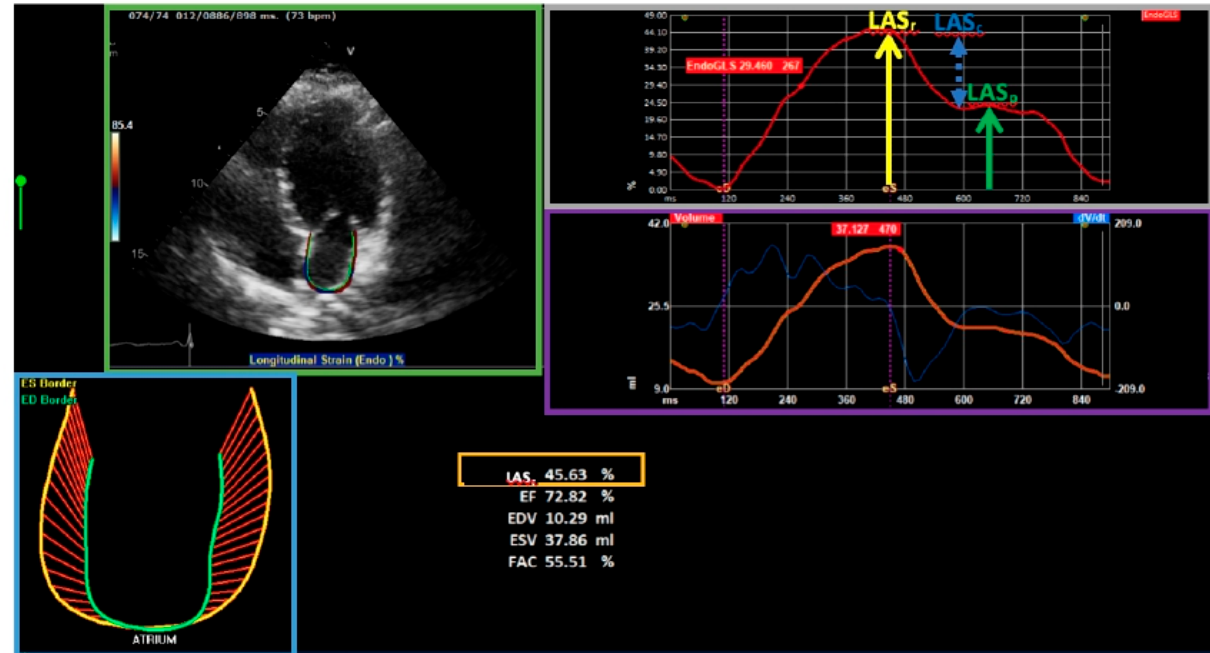
Figure 3. Left atrial strain measurement. Region of interest of the left atrial endocardial border, from the mitral annulus level to the pulmonary veins and/or LA appendage orifice, up to the opposite mitral annulus side were assessed. LASr = left atrial strain during reservoir phase (yellow arrow); LASc = left atrial strain during conduit phase (blue dot arrow); LASp = left atrial strain during atrial contraction phase (green arrow).